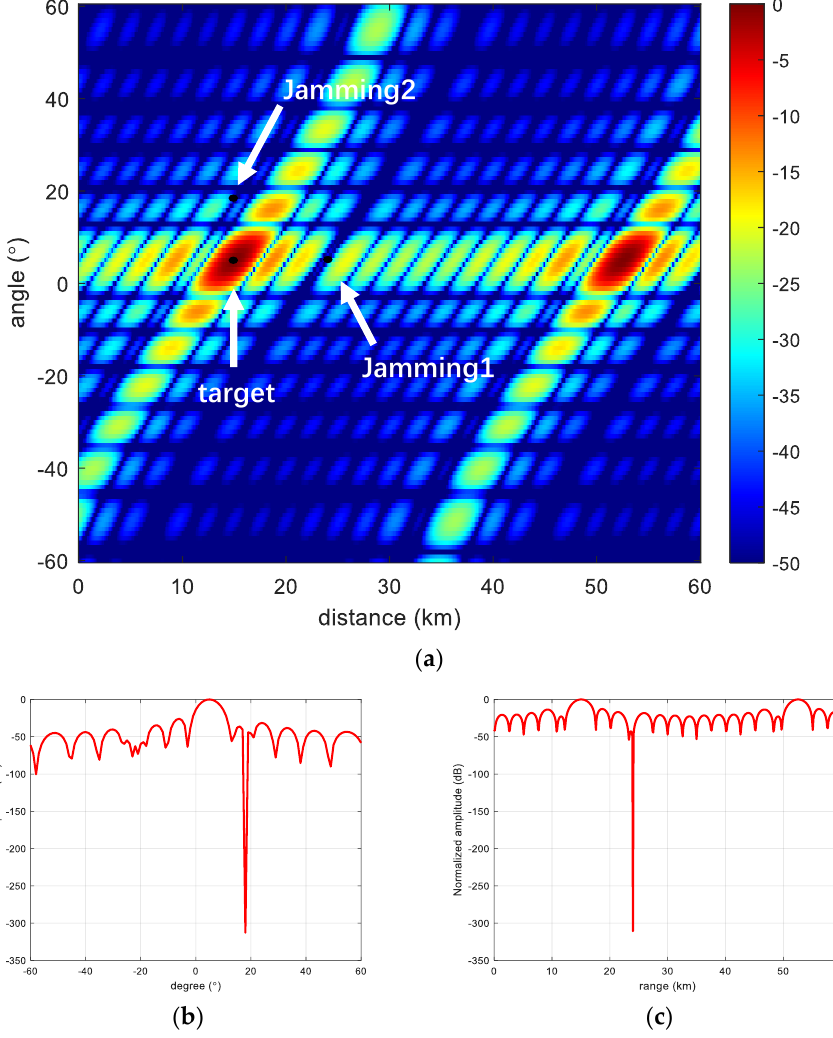
Figure 8. Linear frequency offset FDA-MIMO. ( a ) FDA-MIMO; ( b ) Range-dimensional slicing; and ( c ) Angle-dimensional slicing.